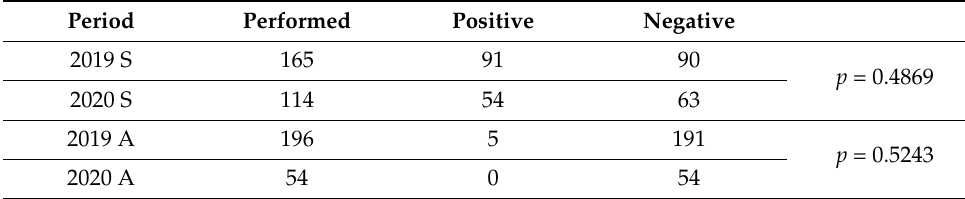
Figure 10. Comparison of Influenza A and B tests. Table 7. Comparison of RSV tests.